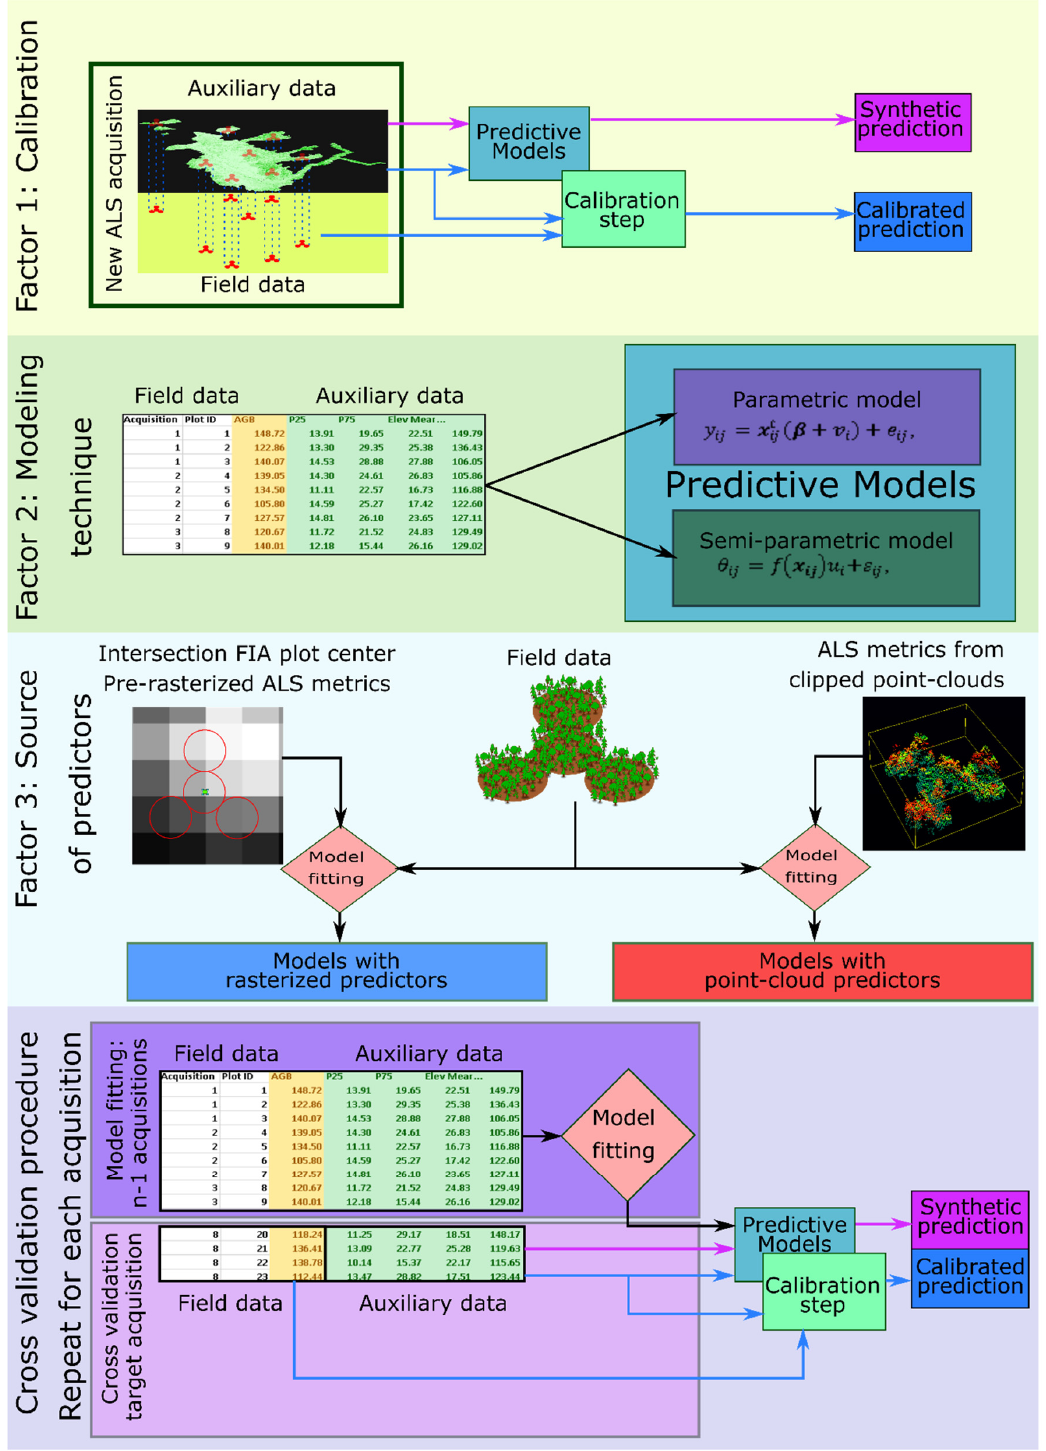
Figure 2. Schematic representation of the three factors analyzed in this study, the computation of ALS metrics and the cross-validation procedure. ALS: Airborne Laser Scanning. FIA: Forest Inventory and Analysis.